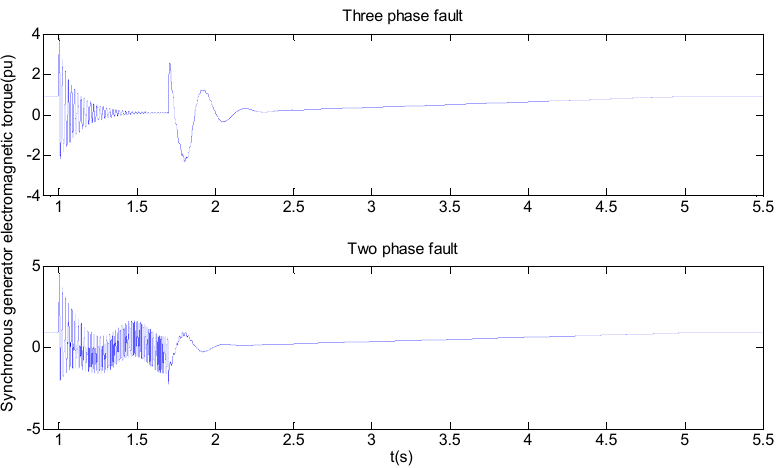
Figure 11. Synchronous generator electromagnetic